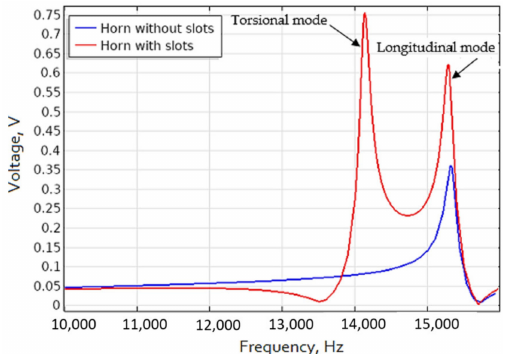
Figure 6. Piezoelectric transducer generated voltage output for tool holder with and without heli- cal